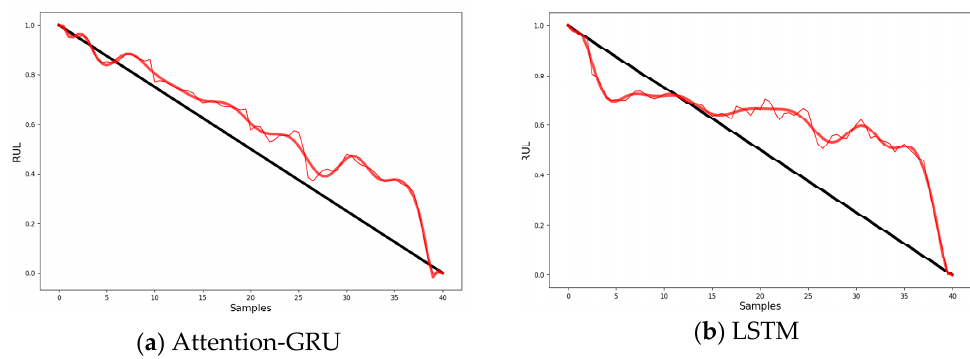
Figure 11. Comparison of RUL prediction results of bearings under working condition 2.